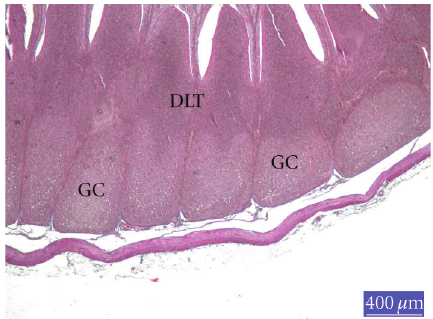
Figure 3: Section from the SR of rabbits from AF-plus-gluco- mannan-treated group, GC: germinal center, DLT: di ff use lymphoid tissue, trichrome staining.